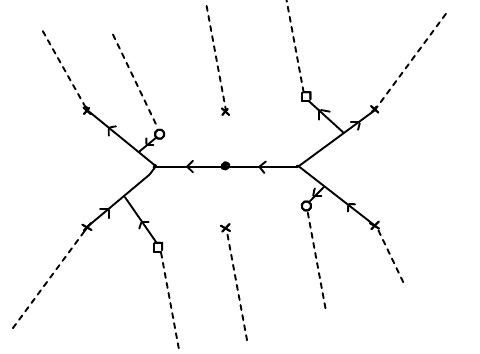
Figure 4 . The class (cid:27) represented as a single string junction corresponding to a two-sphere embedded in the K 3